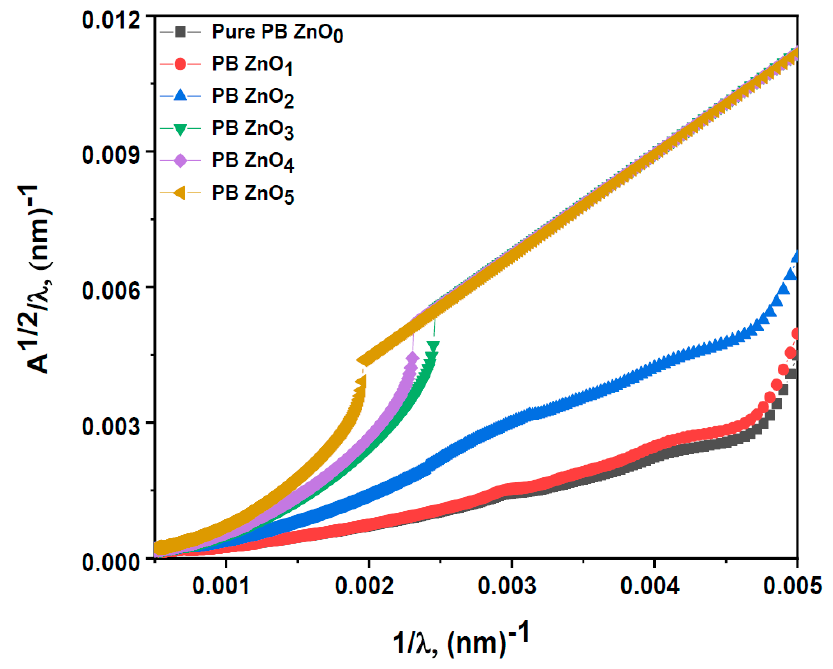
Figure 6. A 1/2 / λ versus 1/ λ for PVA/PVP blend and ZnO polymeric nanocomposite films. = K / E n 4 g , where K is equal to 108 R